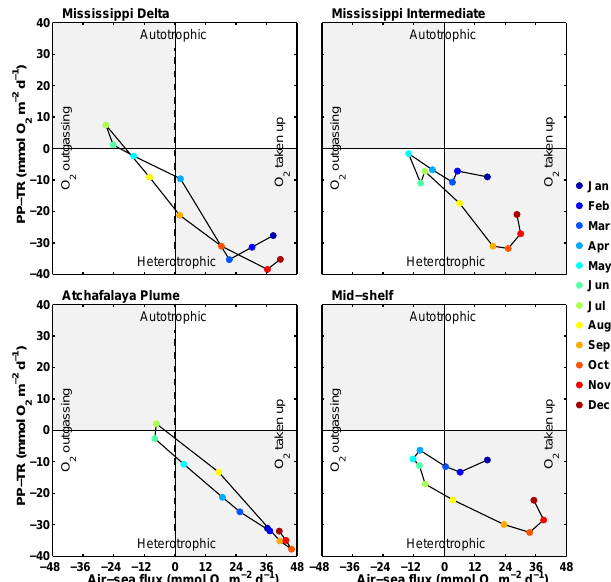
Figure 8. Simulated net community production (PP-TR) versus air– sea flux of oxygen for the four sub-regions. The colored dots repre- sent monthly means averaged over 2004–2007. Positive air–sea flux indicates oxygen is taken by water, whereas negative air–sea flux indicates oxygen outgasses. Positive PP-TR suggests autotrophic, whereas negative PP-TR suggests heterotrophic. Standard devia- tions of the air–sea flux in different months and sub-regions range widely from 13 to 58mmolO 2 m − 2 d − 1 and standard deviation of PP-TR range from 12 to 63mmolO 2 m − 2 d − 1 , both of which are higher in Mississippi Delta and Atchafalaya Plume and lower in the other two